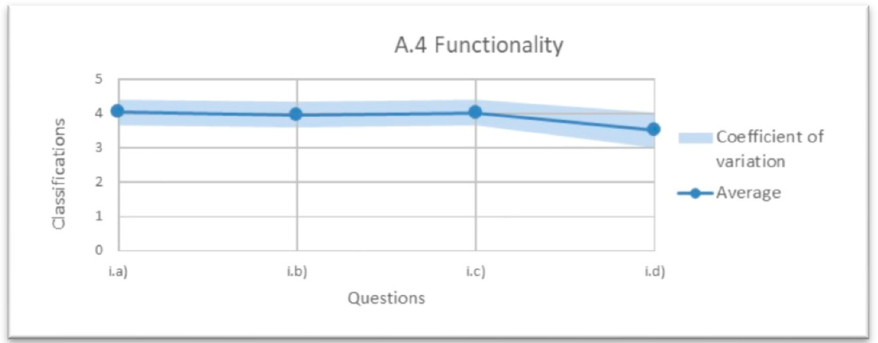
Figure 11. Average ratings of functionality. Table 3. Average ratings of adaptability.